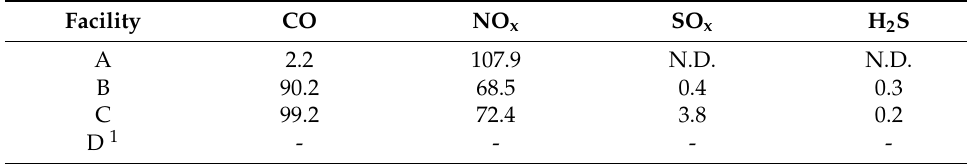
Table 5. Air pollutant concentration from each pyrolysis facility (Unit: